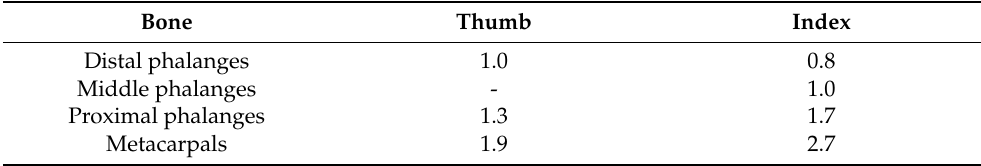
Table 1. Ratio of each phalange when the size of thumb’s distal phalange is set as 1. Bone Thumb Index Distal phalanges